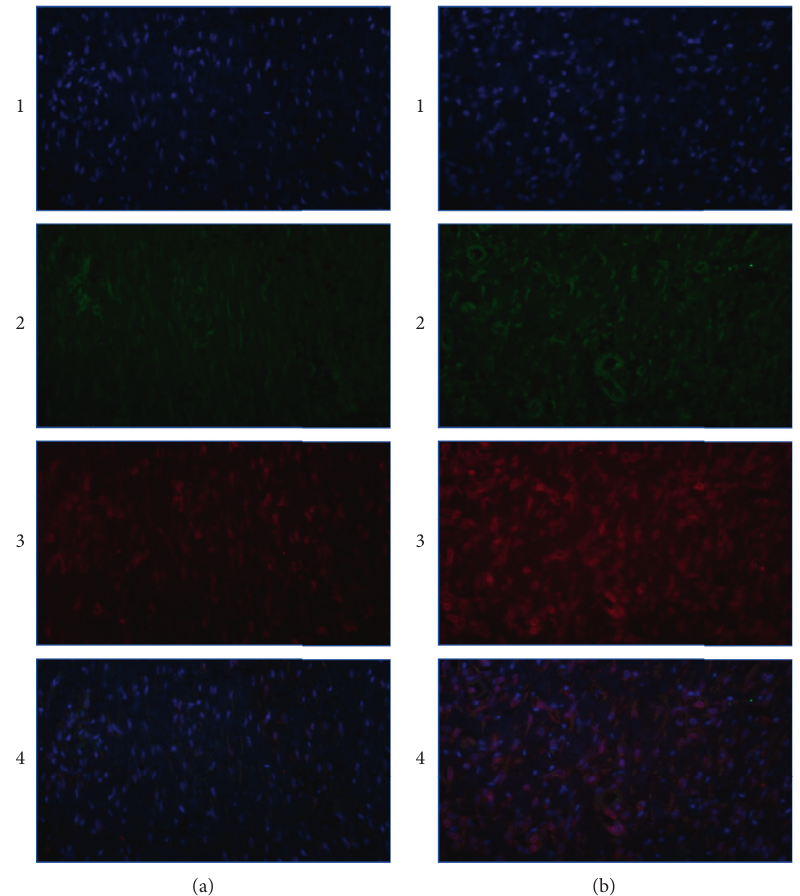
Figure 8: Immunohistochemical staining of COL-1 (2) and CD31 (3) in the wound-healing region at 12 days after different treatments. CS (a); CS/AuNPs